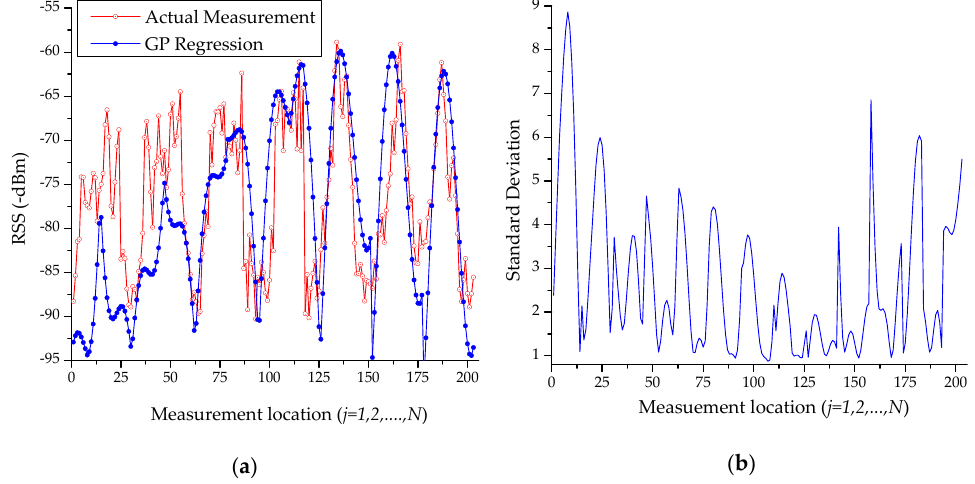
Figure 3. Estimation of beacon 4 signal with GPR ( a ) predicted RSS, ( b ) the corresponding standard deviation at the measurement locations.